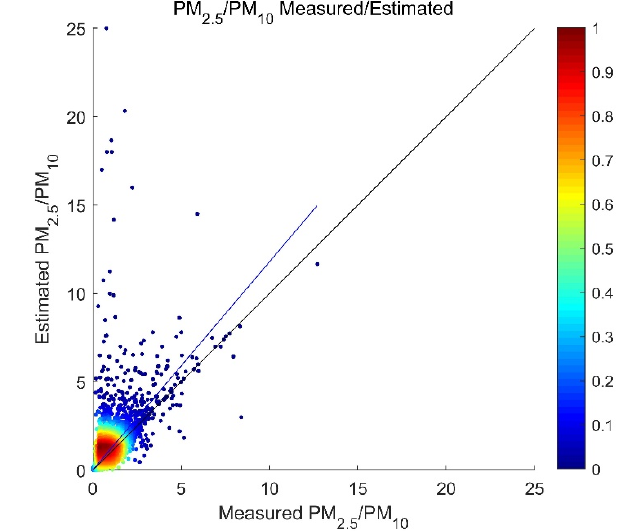
Figure 4. The measured and estimated PM 2 . 5 /PM 10 ratios.